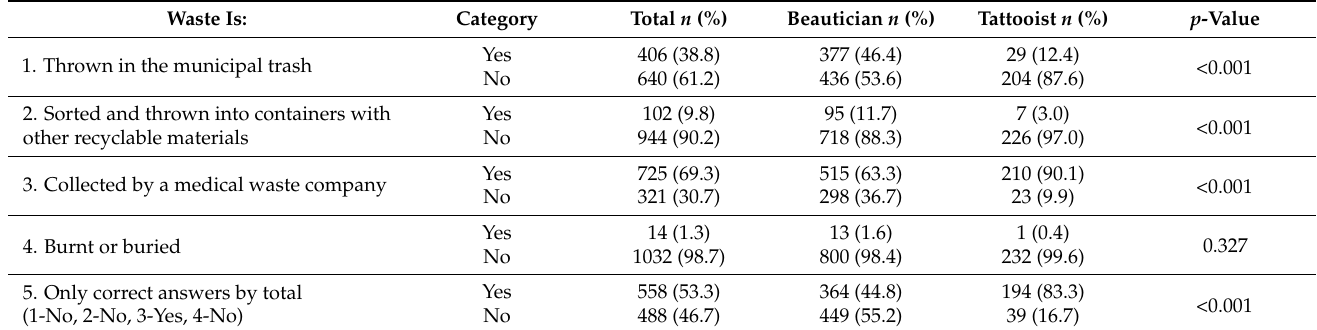
Table 2. Disposal of waste by beauticians and